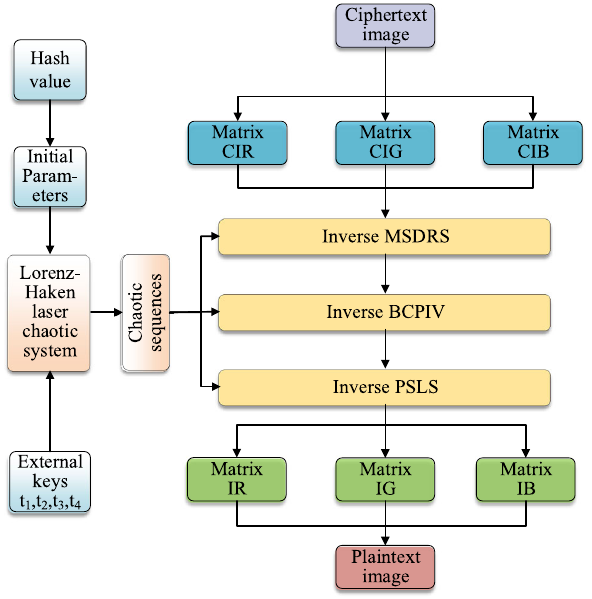
Fig. 7 The flowchart of the proposed decryption